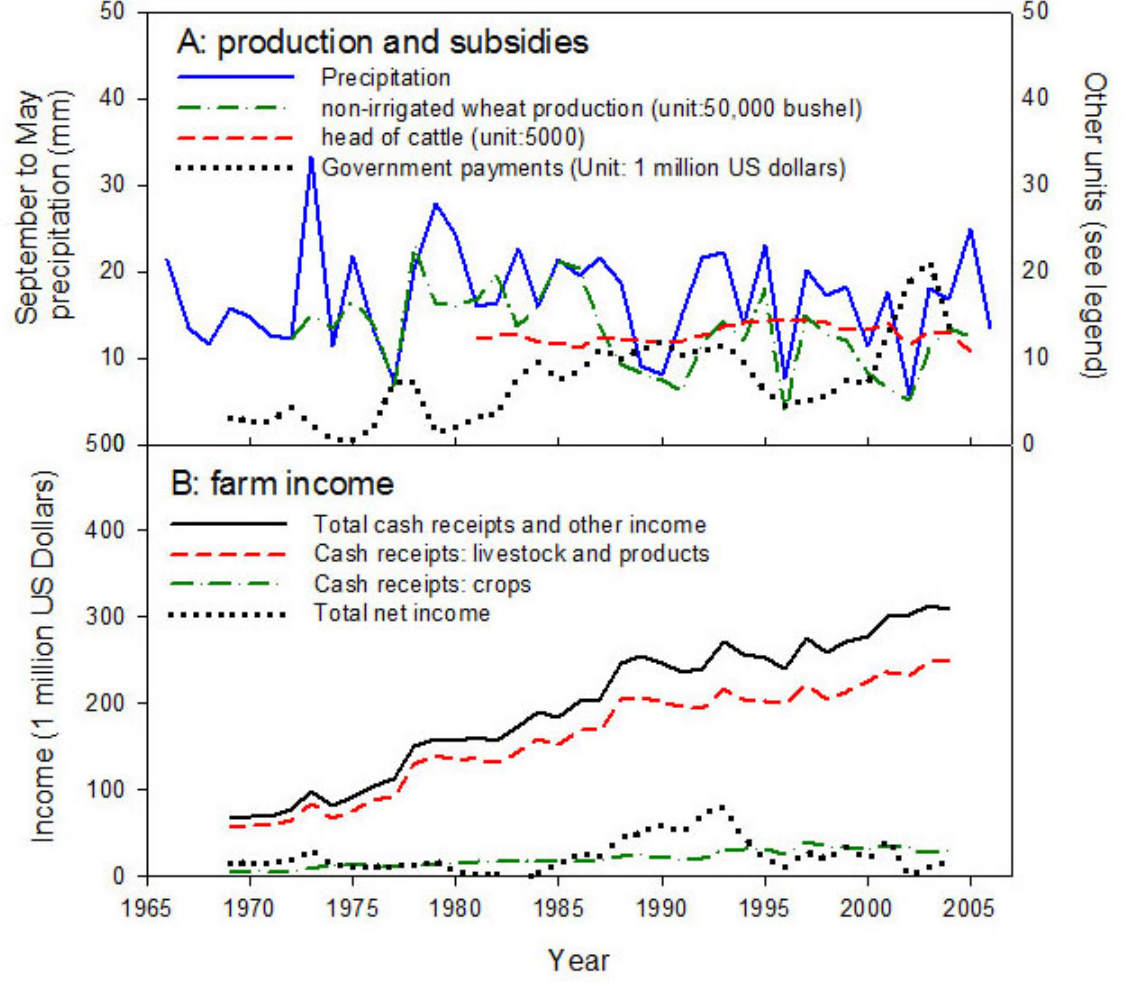
Fig. 4. Farm trends in the Utah section of the Colorado Plateau. A: Dependence of dry-land farming (wheat), cattle numbers, and government payments on September to May precipitation (data source: U. S. Department of Agriculture, Agricultural Statistics Service). Precipitation data are the averages of six precipitation records across the Utah portion of the Colorado Plateau (data courtesy of the Western Regional Climate Center). B: Farm income trends (data source: U.S. Department of Commerce, Bureau of Economic